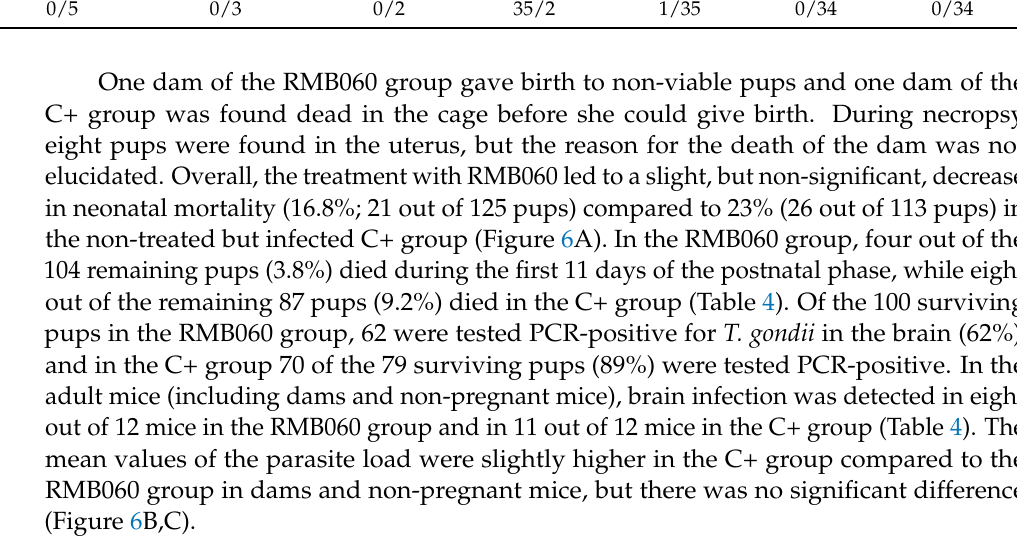
Table 4. Litter size, parasite burden, neonatal and postnatal mortality rates of T. gondii infected and RMB060 treated mice.